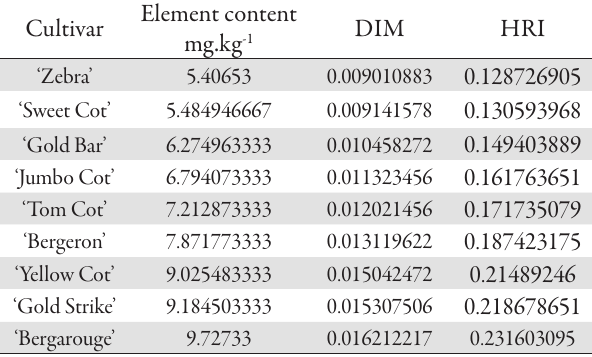
Tab. 1. Health Risk Index (HRI) and Daily Intake of Metals (DIM) calculated for Al’s content of examined Hungarian